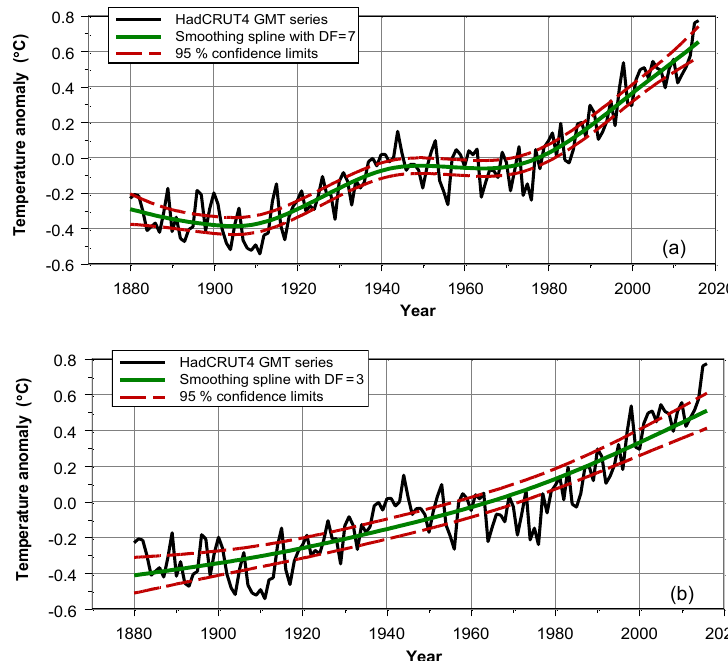
Figure 4. Two smoothing spline estimates for the HadCRUT4 GMST series, with uncertainties generated by MC simulation. All confidence limits are based on 1000 surrogate GMST series following the approach set out in Mudelsee (2014 – Sect. 3.3.3). (a) AR(1) parameter chosen as ϕ = 0 . 28 (equivalent to 7 degrees of freedom), the low end of ϕ values within CMIP5 PiControl runs. (b) AR(1) parameter chosen as ϕ = 0 . 60, the high end of ϕ values (DF = 3).